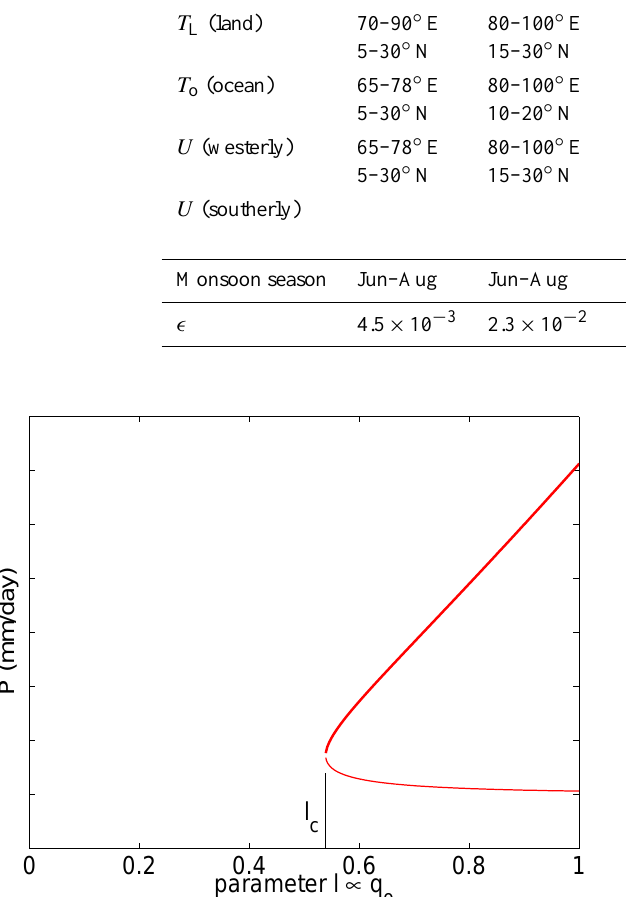
Fig. 7. As Fig. 6, but in terms of dimensional precipitation P . The shape of the solution is different than in terms of p , because the relation between p and P depends on l . Units on the y-axis are arbitrary.